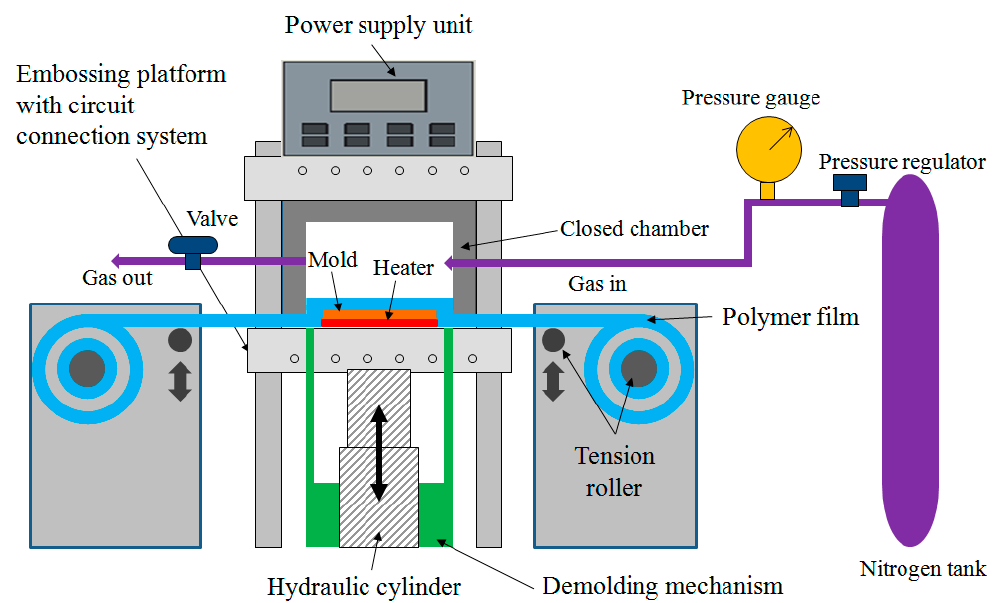
Figure 4. Drawing of the gas-assisted hot embossing facility with nonuniform heating system. In the experiment, a roll of optical PC film was used as the hot embossing substrate. The glass transition temperature and thickness of the PC film were 140 ◦ C and 0.18 mm, respectively. To further investigate the production quality of the hot embossing of polymers with multiscale microstructures, we applied different voltages to the graphene-based heater with three heating zones. The temperature distributions in each zone of the graphene- based heater were measured using a thermal imaging camera (DONHO & Co., Ltd., Taiwan). The practical embossing temperatures were determined using thermocouples placed in the embossing stack. The embossing temperatures at different temperature zones were controlled and adjusted in the hot embossing process. Finally, the shape and dimensions of the fabricated microstructure patterns were characterized using a scanning electron microscope (Hitachi S-3000N, Japan) and a laser scanning confocal microscope (VK-X1000; Keyence, Taiwan). Thus, a 2D surface profile and average cross-sectional area of the fabricated polymer microstructures were obtained. The average replication ratio of the fabricated microstructure was also estimated (replication ratio = cross-sectional area of fabricated microstructure/cross-sectional area of microstructure cavity of mold). In the experiments, all the cross-sectional area of fabricated polymer microstructures were measured at various locations of polymer substrates; each sample was measured at nine different measurement